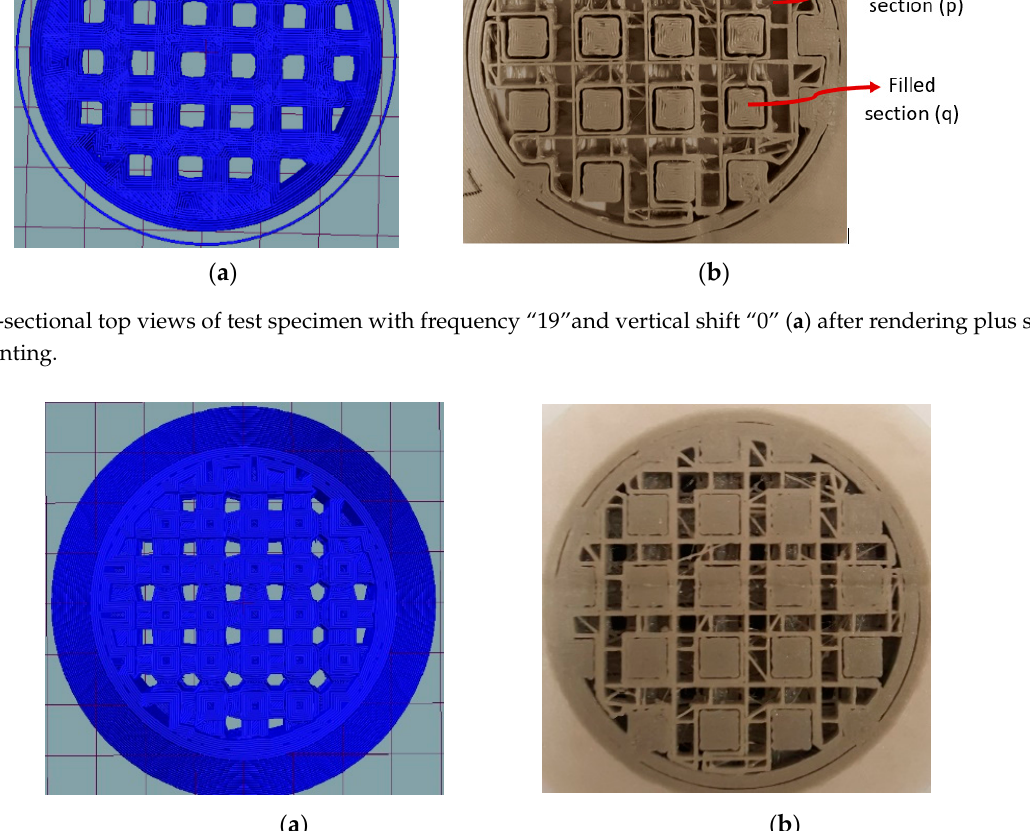
Figure 6. X-sectional top views of test specimen with frequency “19” and vertical shift “0.4” ( a ) after rendering plus slicing ( b ) after printing.